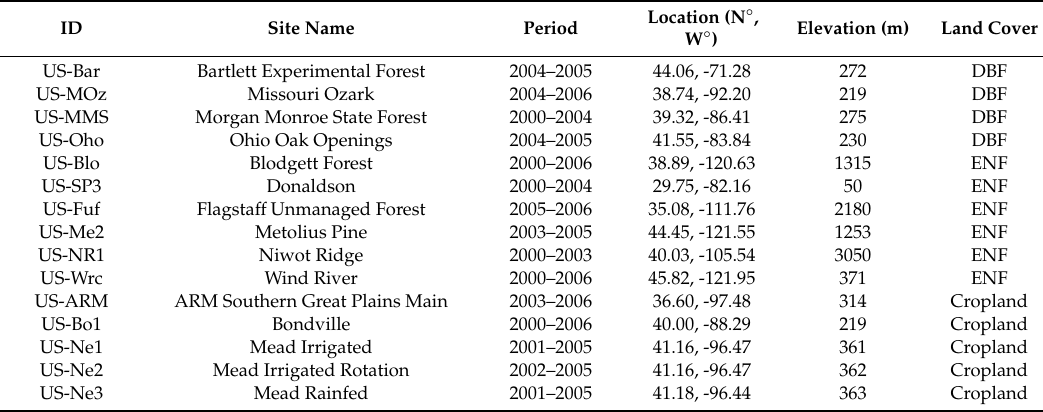
Figure 1. The land cover types and location of the 15 AmeriFlux stations over the contiguous United States (CONUS). DBF, EBF, and ENF represent deciduous broadleaf forest, evergreen broadleaf forest, and evergreen needleleaf forest, respectively. Table 1. Characteristics of the 15 AmeriFlux stations over the contiguous United